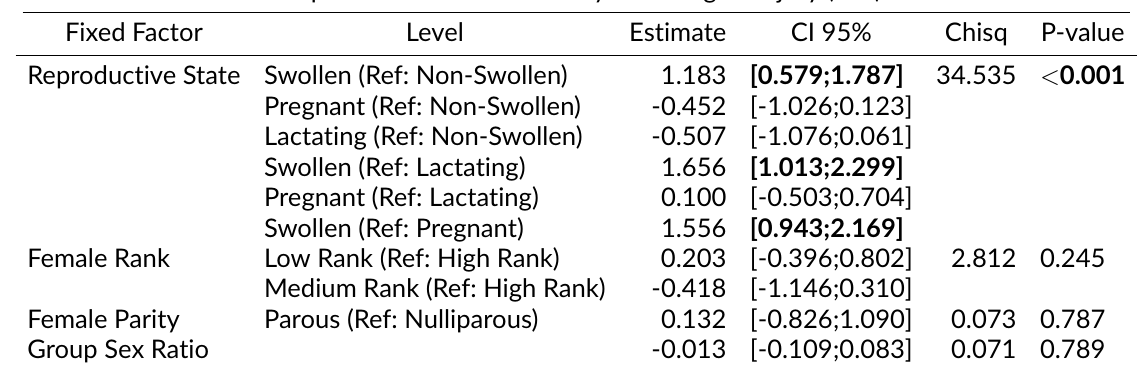
Table 2 – Injuries in relation to female reproductive state (for sample sizes, see